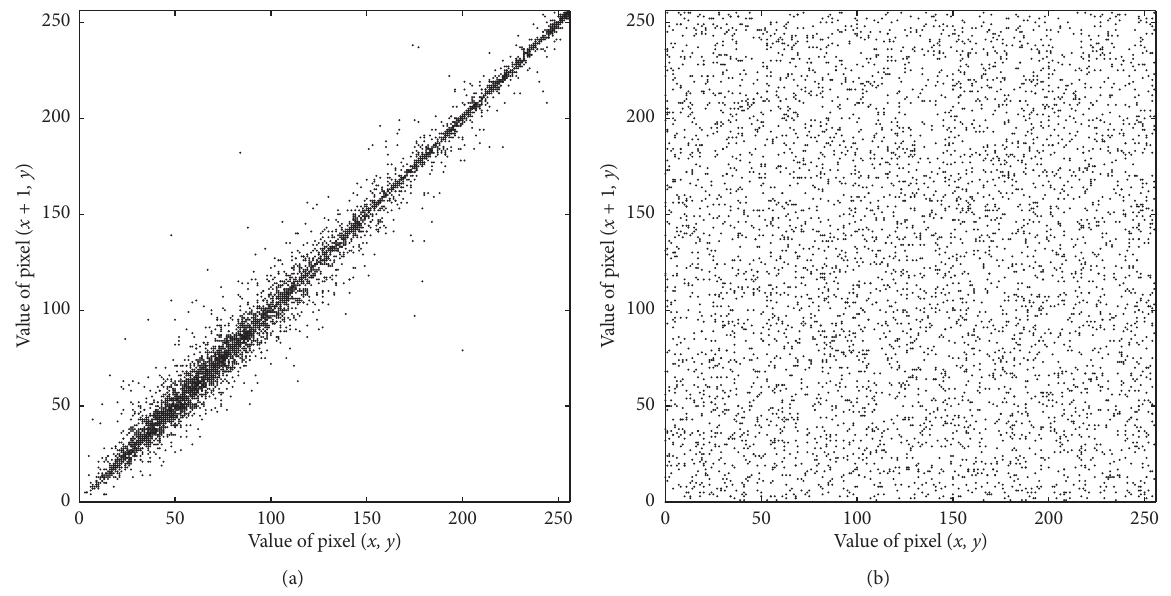
Figure 8: Correlation analyses for the original and encrypted figures in Figure 6. (a) Correlation analysis for the original figure as shown in Figure 6(a). (b) Correlation analysis for the encrypted figure as shown in Figure